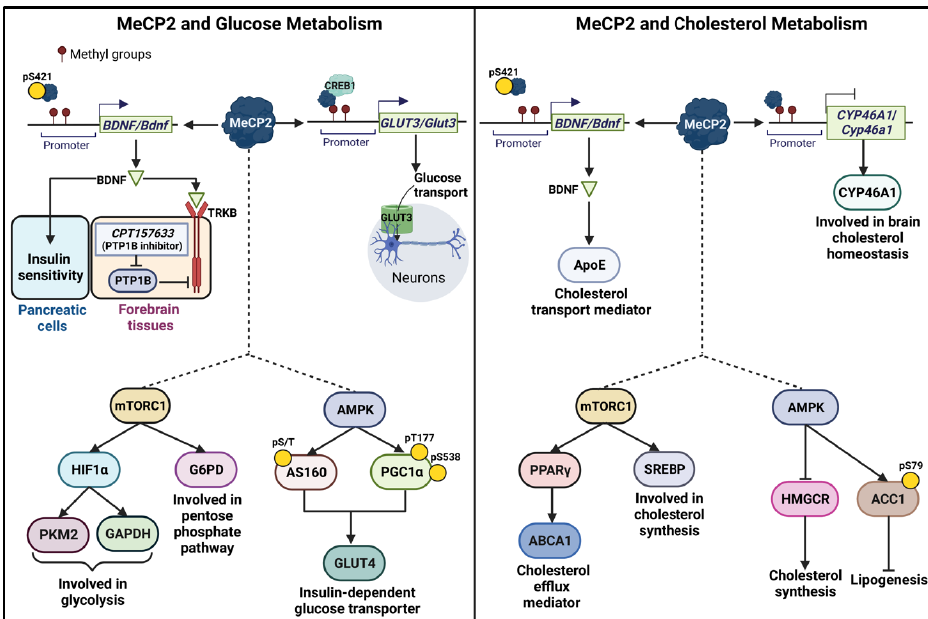
Figure 4. The potential links between MeCP2 with glucose and cholesterol metabolism. Brain-derived neurotrophic factor (BDNF), a downstream target of MeCP2, is engaged in both glucose and cholesterol metabolism; similar to mTORC1 and AMPK signaling pathways. Moreover, MeCP2 may regulate the expression of CYP46A1, which is a key factor in brain cholesterol homeostasis. MeCP2 promotes expression of GLUT3, which is a crucial transporter of glucose to neurons. ABCA1: ATP binding cassette subfamily A member 1; ACC1: acetyl-CoA carboxylase 1; AMPK: adenosine 5′ - monophosphate activated protein kinase; AS160: Akt substrate of 160 kDa; BDNF: brain-derived neurotrophic factor; CREB1: cAMP response element-binding protein 1; CYP46A1: cytochrome P450 family 46 subfamily A member 1; G6PD: glucose-6-phosphate dehydrogenase; GAPDH: glyceraldehyde-3-phosphate dehydrogenase; GLUT3: glucose transporter 3; GLUT4: glucose transporter 4; HIF1 α : hypoxia- inducible factor 1-alpha; HMGCR: 3-hydroxy-3-methyl-glutaryl-CoA reductase; MeCP2: methyl-CpG Binding Protein 2, mTORC1: mechanistic target of rapamycin complex 1; PGC-1 α : peroxisome- proliferator-activated receptor gamma coactivator 1 alpha; PKM2: pyruvate kinase M2; PPAR γ : peroxisome proliferator-activated receptor gamma; PTP1B: protein tyrosine phosphatase 1B; SREBP: sterol regulatory element-binding protein, TRKB: tropomyosin receptor kinase B. Information ob- tained from [18,150,159–183]. Please note that the molecular signaling cascades showing the link between MeCP2 and glucose metabolism as well as cholesterol metabolism were taken from different organs and cell type-specific regulation. Figure is created with